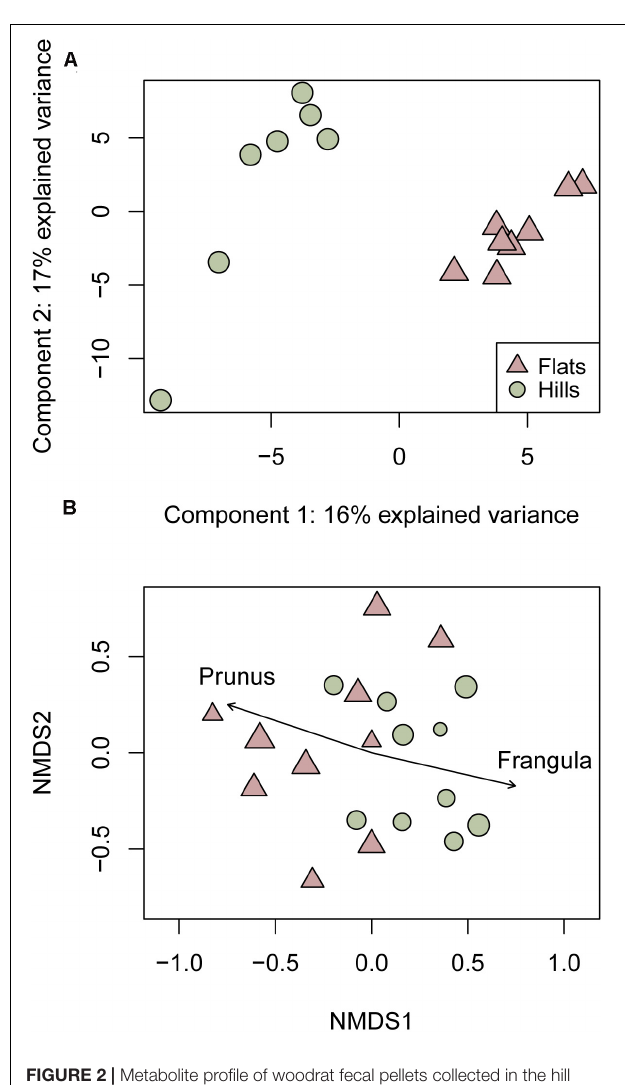
FIGURE 2 | Metabolite profile of woodrat fecal pellets collected in the hill (green) and flats habitats (pink). (A) PLS-DA of 1 H-NMR chemical profiles in each habitat. (B) NMDS plot of HPLC-MS chemical profiles showing that chemical differences in woodrat feces are associated with the proportion of Prunus fasciculata and Frangula californica DNA in the feces. Point size reflects RRA of Prunus and Frangula , no individuals were found to consume both